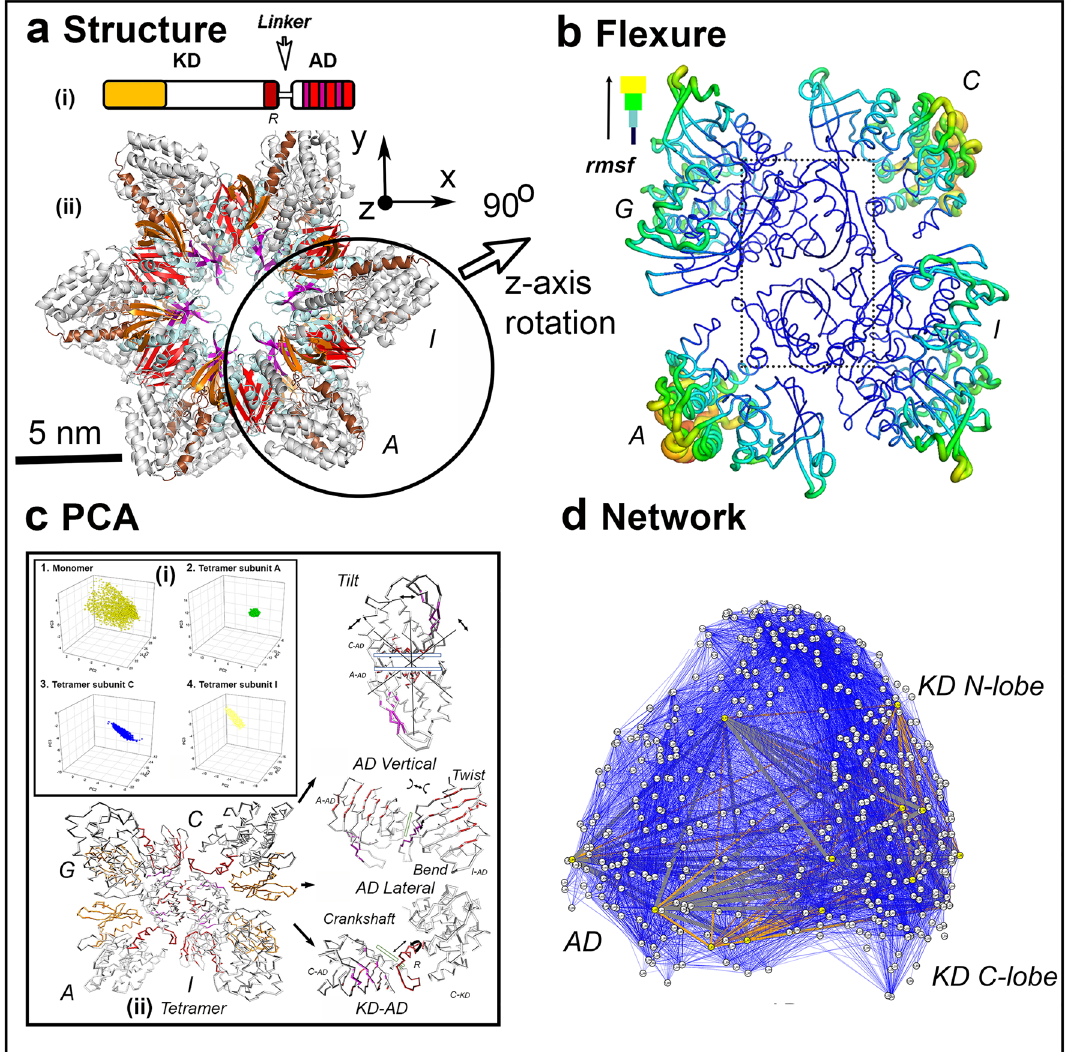
Figure 1. ( a ) Architecture. (i) Subunit. Disordered linkers with varying lengths and composition connect the kinase domain (KD (N-lobe (orange), C-lobe (white)) with the association domain (AD). The pseudo-substrate, regulatory segment (R (brown) binds Ca 2+ /CaM. The AD β-sheet forms vertical (red) and lateral (magenta) ring contacts. (ii) Assembly. The ADs form the central hub in the multi-subunit holoenzyme (CaMKIIα 3SOA.PDB). A tetramer (circle) was extracted for analysis of conformational fluctuations. ( b ) Flexure. The flexibility (rmsf)) profile derived from the tetramer conformational ensemble. The tetramer orientation shown is rotated by 90° relative to the orientation in panel a (Supplementary Video S1). ( c ) Principal Component Analysis (PCA). (i). PCIPC2PC3 plots of the human CaMKIIα AD; (ii) A conformation in the CaMKIIα tetramer tCONCOORD ensemble (Supplementary Video S2) used for PCA, with PCs 1–3 mapped onto the key contacts (AD Vertical (Vert-Dim), Tilt. AD Lateral (Lat-Dim), Bend and twist. KD–AD. Crankshaft (extension + rotation)). Rectangles represent β sheet long axes. ( d ) Monomer network. Nodes = Residues (Circles). Edges = Dynamic couplings between 4-residue fragments (lines color-coded according to nMI score (high (orange) → low (blue)). Source listed in Table tion. The score ( S s ) represented the evolutionary coupling strength between two residue positions, again indica- tive of a functionally important contact. The spur KD–AD contact coupled AD fluctuations to α-helices in the KD C-lobe (Fig. 2a). The contacts made by the regulatory segment R with both the KD C-lobe and AD were energetically stressed based on the ΔE fr scores (Fig. 2b). Interfacial couplings that propagated across and along the two stacks dominated the AD dynamic network. The Vert-Dim dynamic couplings connected the β 2 –β 4 sheet center in one AD with the α 2 –β 1 and β 3 –β 4 loops in the other AD across the rigid (β 3 –β 4, β 6 strands, α 2 –α 3 loop) contact. The top (1%) dynamic couplings at the Lat-Dim contact of helix α 3 with the adjacent β 3 –β 5 loops, changed AD β-sheet curvature (Fig. 2c). The ΔE fr profiles revealed the energetic cost of the evolution of CaMKIIα Lat-Dim contact (Fig. 2d). Its structural elements formed stressed interactions relative to the relaxed contacts associated with the Vert-Dim interface.